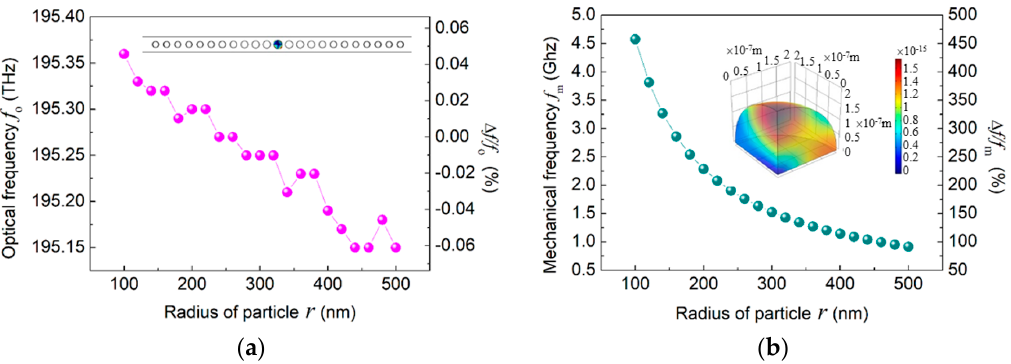
Figure 5. ( a ) The optical frequency shift for the particle with different radius, ranging from 100 nm to 500 nm. The relative changing percent of the optical resonant frequency of the cavity, ∆ f / f o , was also calculated. Here, the polystyrene particle is located at ∆ x = 190 nm, ∆ z = 5 nm. The inset shows the configuration for the detected nanobeam cavity with the particle above the cavity. ( b ) The mechanical frequency shift and the relative changing percent of the mechanical frequency of the cavity, ∆ f / f m for the particle with a different radius. The inset shows the strain for the vibrated particle with a radius of 200 nm.